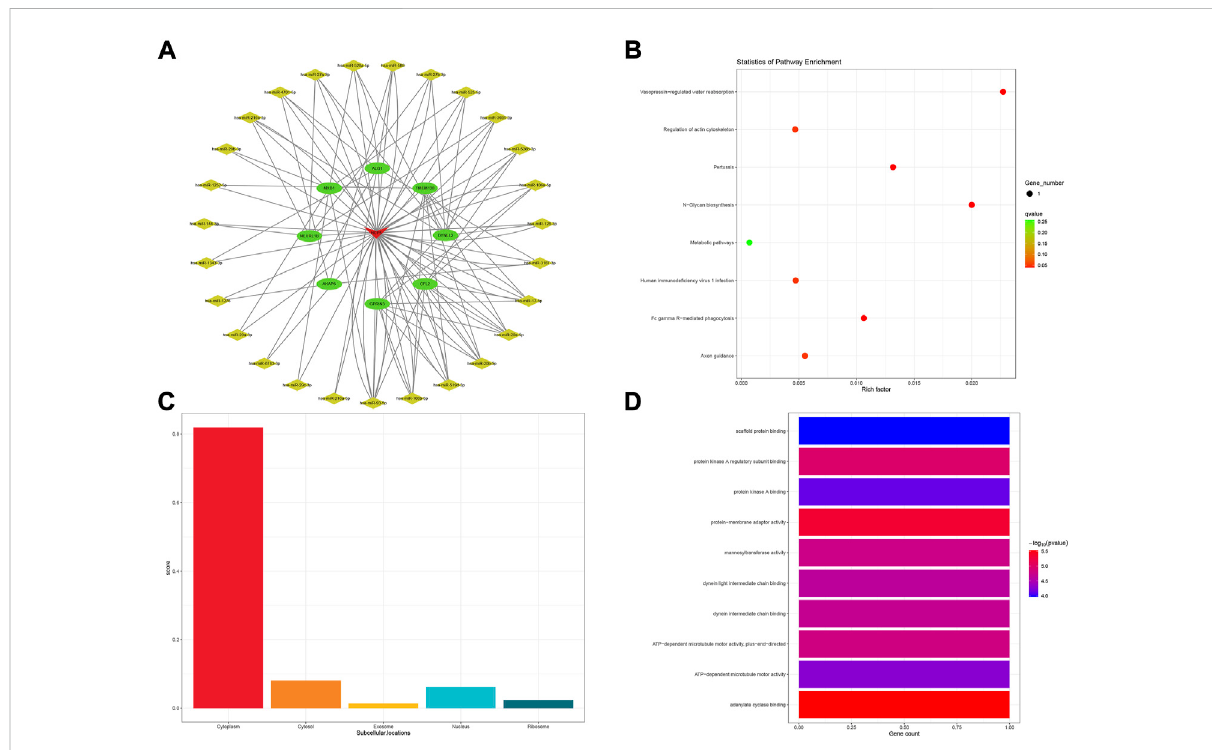
FIGURE 4 HCP5-related ceRNA subnetwork analysis. ceRNA network of HCP5 (A) . KEGG pathways enriched in HCP5 (B) . Subcellular location analysis for HCP5 (C) . GO biological process enrichment results for HCP5 (D)